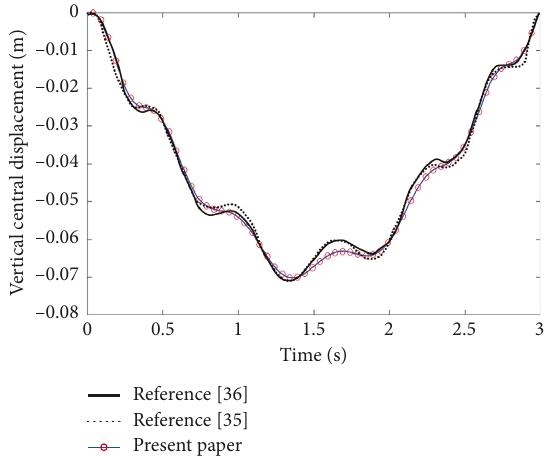
Figure 8: Calculation results of central displacement position deflection compared to references [38, 39].